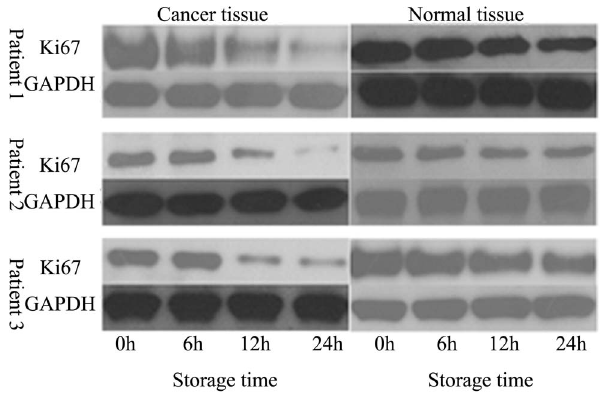
Figure 6. Expression of Ki67 following organ preservation. Protein samples were separated by SDS-PAGE, transferred onto membranes, and probed with anti-Ki67 antibodies. Stripped mem- branes were re-probed with anti-GAPDH antibodies as a loading control.